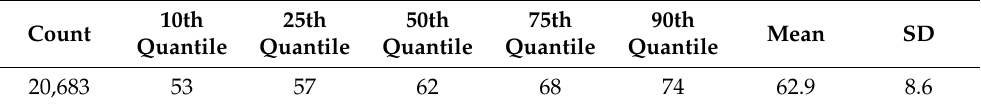
Table 1. Descriptive statistics of the male